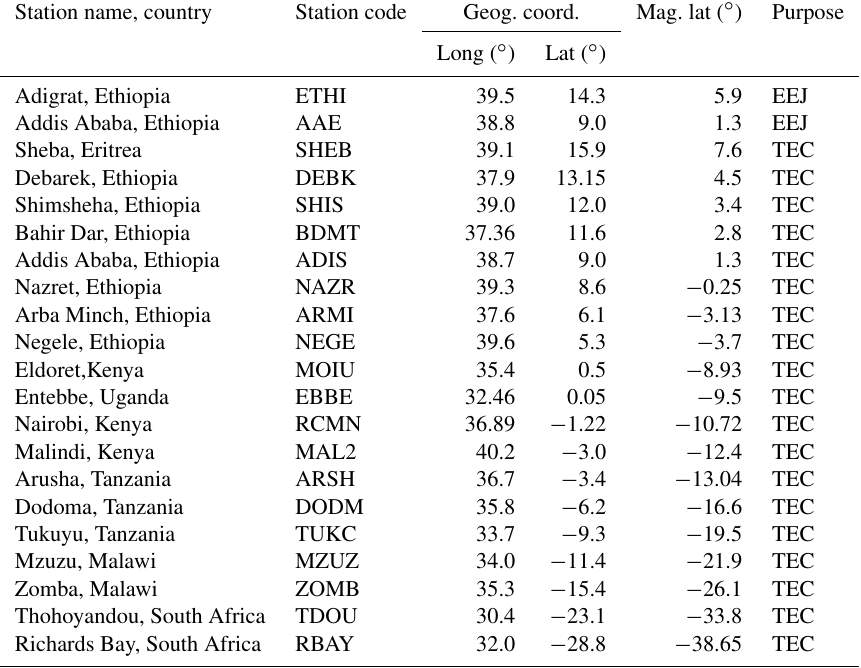
Table 1. Sites of GNSS receivers and magnetometers used in the study. Station name, country Station